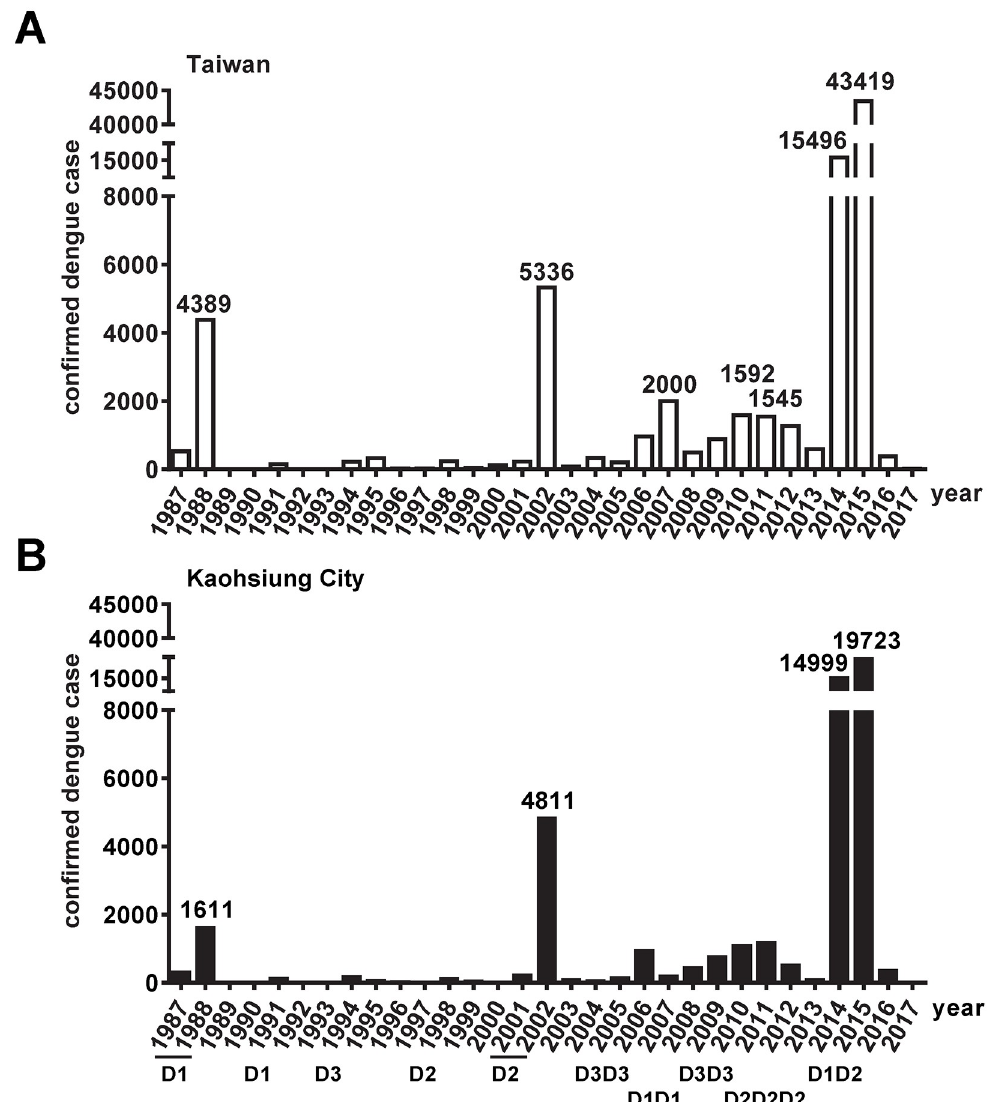
Fig 1. Dengue outbreaks in Taiwan from 1987 to 2017. Laboratory-confirmed indigenous dengue cases in Taiwan (A) and Kaohsiung City (B), based on data from CDC Taiwan [18]. Numbers of cases in major outbreaks ( > 1,500 cases) and the principal DENV serotype of each outbreak in Kaohsiung City are shown